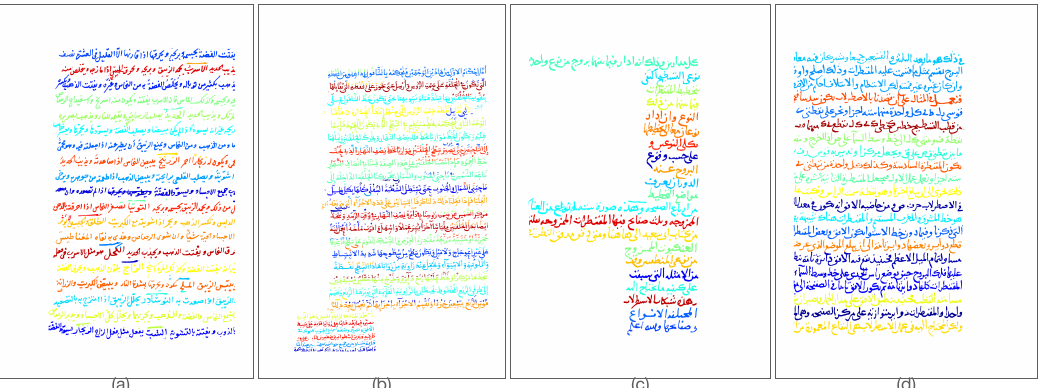
Figure 13. Example results from RASM2018 dataset. Some errors occur due to non-textual elements such as the underlines in ( a ). Some errors occur because of satellite textual elements are grouped separately ( b ). Text lines with heterogeneous lengths ( c ). Touching characters are split but not very adequately ( d